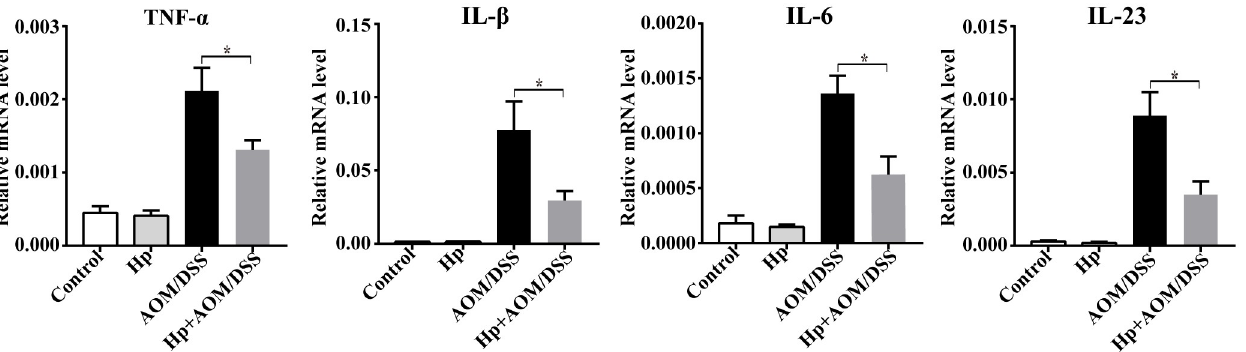
Fig 5. H . pylori infection regulated the pro-inflammatory and pro-tumorigenic cytokines expression in CAC mice. Relative mRNA expression of pro- inflammatory and pro-tumorigenic cytokines (TNF- α , IL-1 β , IL-6 and IL-23) in colonic tumors (n = 5-6/group). Data are represented as mean ± SEM. � P <